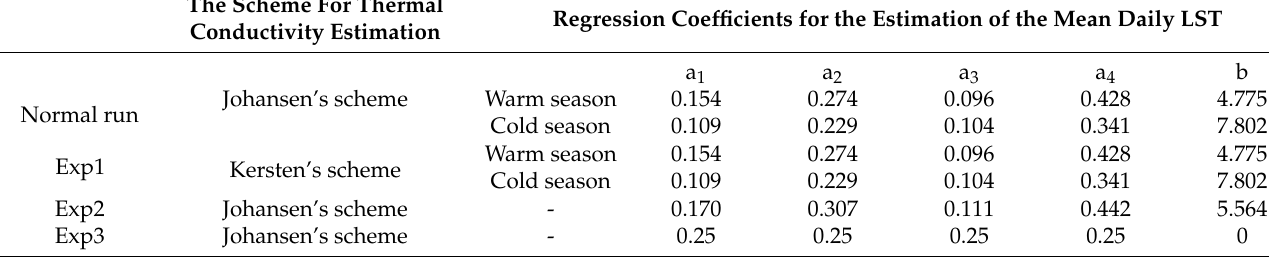
Table 3. Comparison of the parameterization of the frozen soil mapping in the normal run, exp1, exp2, and exp3. The Scheme For Thermal Conductivity